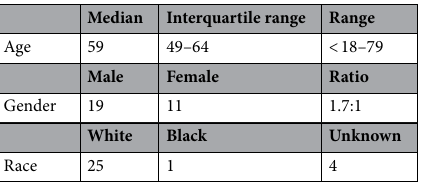
Table 1. Patient Demographics for GENIE Gliosarcoma Samples (n =